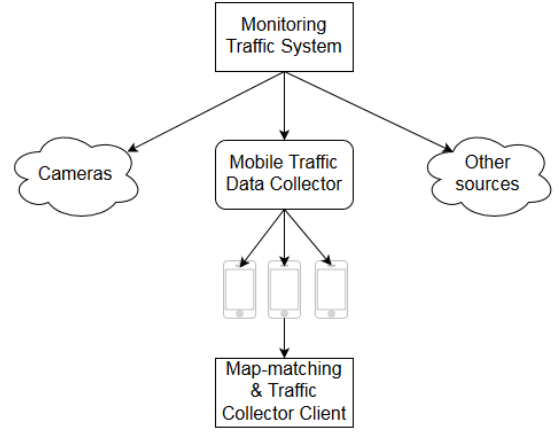
Figure 1. Architecture of traffic monitoring via mobile devices. Table 1. Most commonly used traffic vehicle